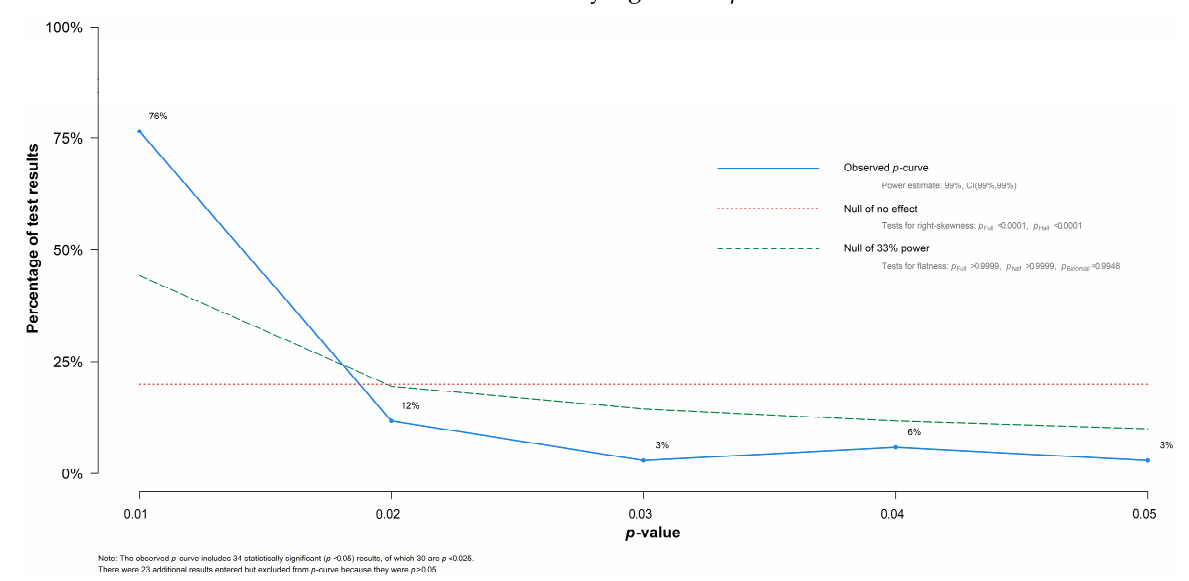
Figure 4. P -curve was used to assess publication bias and detect p